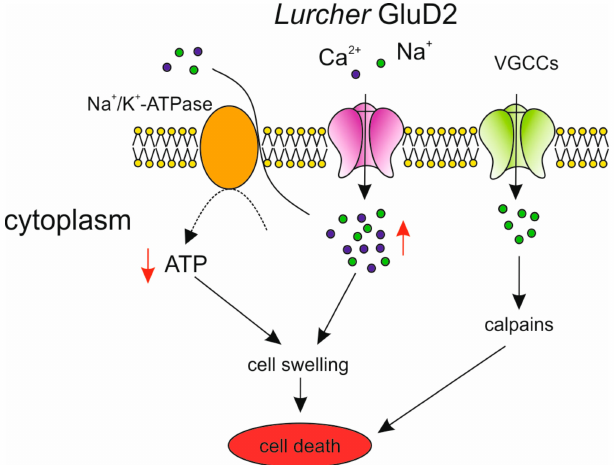
Figure 1. Lurcher δ 2 glutamate (GluD2)-induced cell death. Lurcher GluD2 receptors show constitutive andcontinuousinfluxofNa + andCa 2 + .IntracellularATPlevelsaredecreasedprobablybyoveractivation of the Na + / K + -ATPase. Compromised ionic homeostasis together with decreased ATP levels can lead to cell swelling and subsequent cell death. Secondary Ca 2 + influx through voltage-gated Ca 2 +